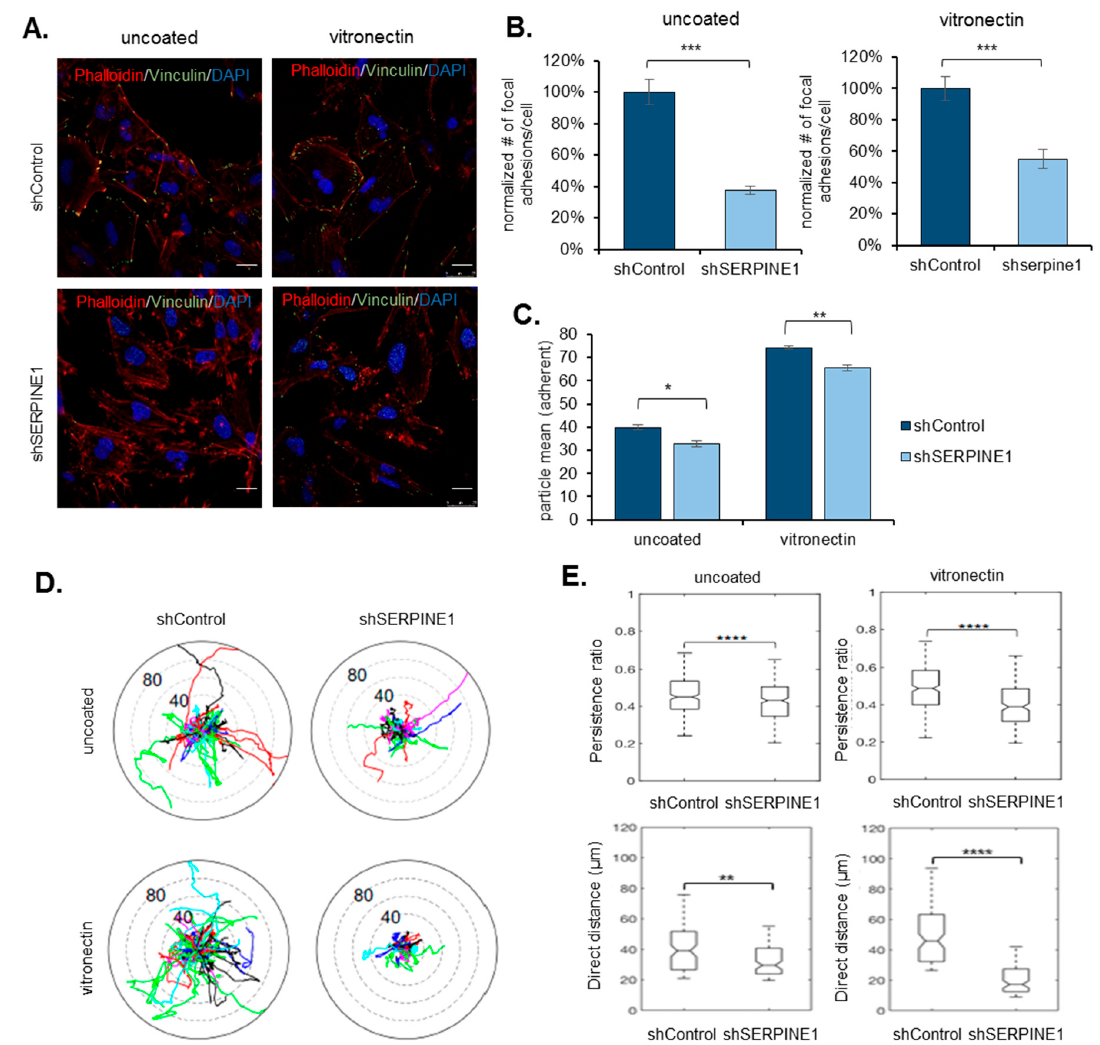
Figure 3. SERPINE1 knock-down reduces cell adhesion and directional persistence of GBM cells ( A ) immunofluorescence staining for shControl and sh SERPINE1 U373 cells (red: phalloidin, green: vinculin, blue: DAPI, scale bar: 200 µm) with/without vitronectin coating. ( B ) Analysis shows that the number of focal adhesions per cell is significantly reduced with SERPINE1 knock-down ( n = 20 cells analyzed for each condition). ( C ) Adhesion analysis for shControl and shSERPINE1 U373 cells (three wells/condition were analyzed, adherent particles were measured two hours after cell seeding); ( D ) polar plot obtained by tracking movement of individual shControl or shSERPINE1 cells with no coating or on vitronectin coating (>200 cells per condition tracked); ( E ) persistence ratio (top) or direct distance taken (bottom) for movements of shControl or shSERPINE1 cells with no coating or on vitronectin coating (>200 cells per condition tracked). (*, **, *** and **** denote p < 0.05, p < 0.01, p < 0.001 and p < 0.0001 respectively, two-tailed Student’s t -test).